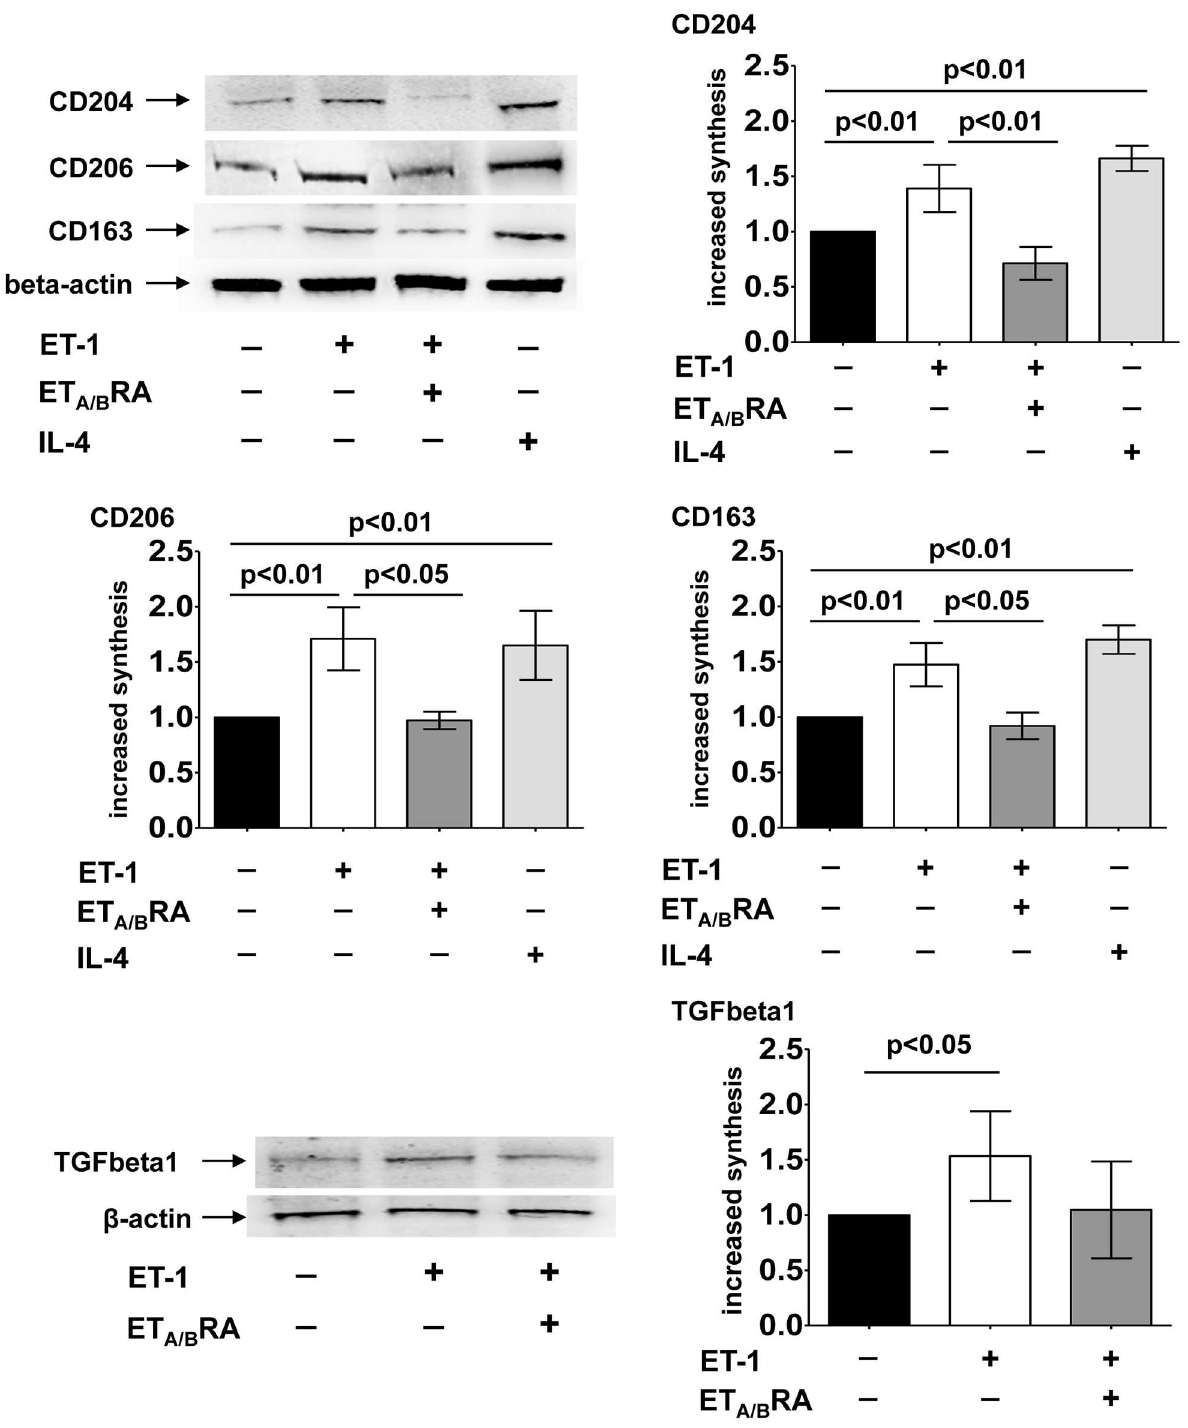
Fig 4. Evaluation of protein synthesis of M2 phenotype markersand TGFbeta1 in cultured human monocyte-derived macrophages. Western blotting and related densitometric analysisof CD204, CD206, CD163 and TGFbeta1 protein synthesis in cultured humanmonocyte-derived macrophages treated for 6 days with ET-1 (100nM) and IL-4 (10ng/mL) alone, or pre-treatedwith ET A/B RA (bosentan, 10 -5 M) for 1 hour before being stimulatedwith ET-1. Culturedhuman monocyte-derivedmacrophages maintained for 6 days in RPMI at 10% of FBS were used as untreated cells. Western blotting was performed on six independent in vitro experiments. The data of CD204, CD206, CD163 and TGFbeta1 protein synthesis are shown as mean ± SDand indicatedas increase in protein synthesis.